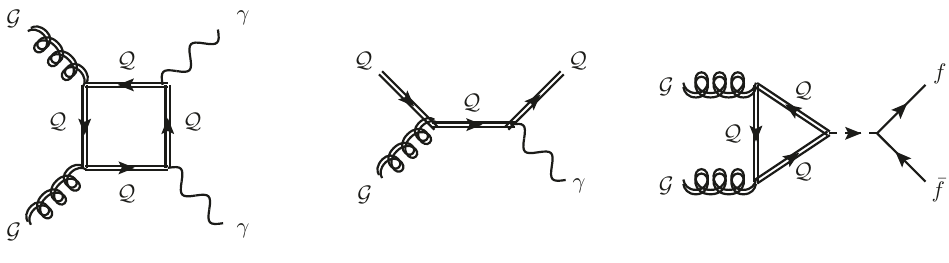
Figure 3 . Leading processes describing interactions between the SM and the dark